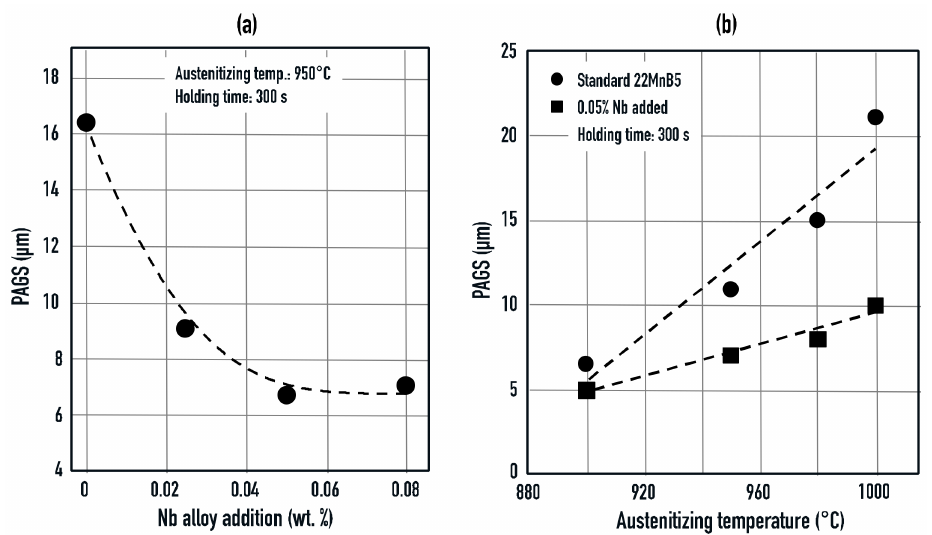
Figure 9. ( a ) Effect of niobium on parent austenite grain size control under typical re-austenitizing conditions used in the automotive press hardening process; ( b ) demonstration of robustness against overheating for a niobium alloyed